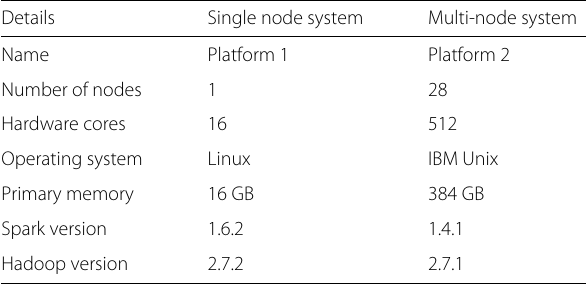
Table 2 Details of the experimental platform used for